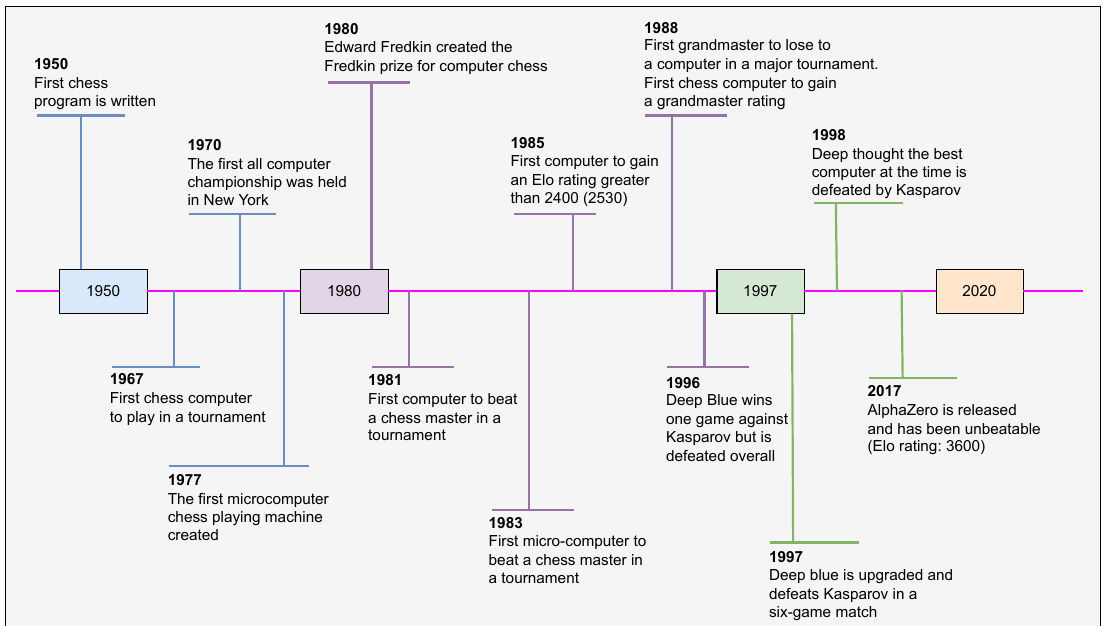
Figure 15. Evolution of chess technology demonstrates the speed of AI